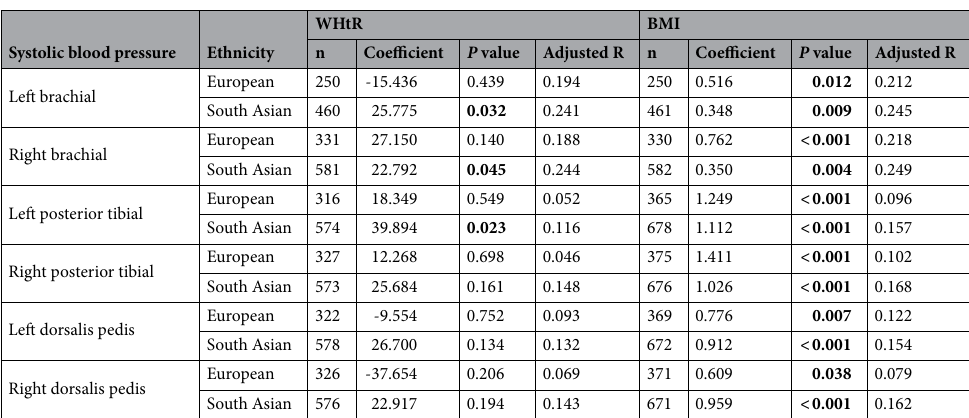
Table 3. Linear regressions comparing the different systolic blood pressures measured against either the waist to height ratio or BMI by ethnic group. Model is adjusted for adjusted for sex, age, cardiovascular disease, and type 2 diabetes mellitus. The ethnicities have been grouped into either European or south Asian (composed of Indian, Pakistani Bangladeshi, and other south Asian ethnicities).